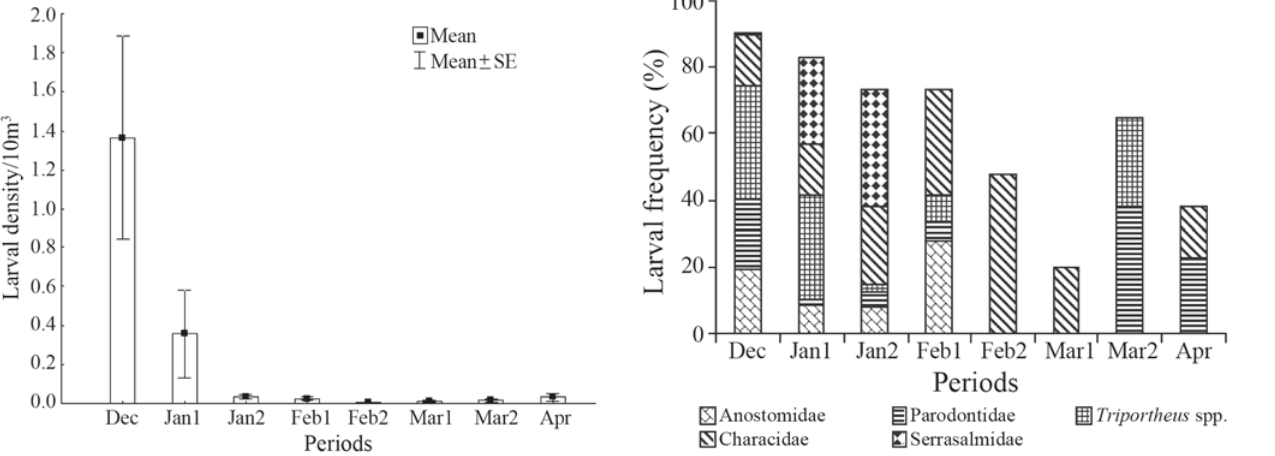
Fig. 4. Temporal distribution of fish larvae in marginal lagoons along the Cuiabá River between December 2006 and April 2007.